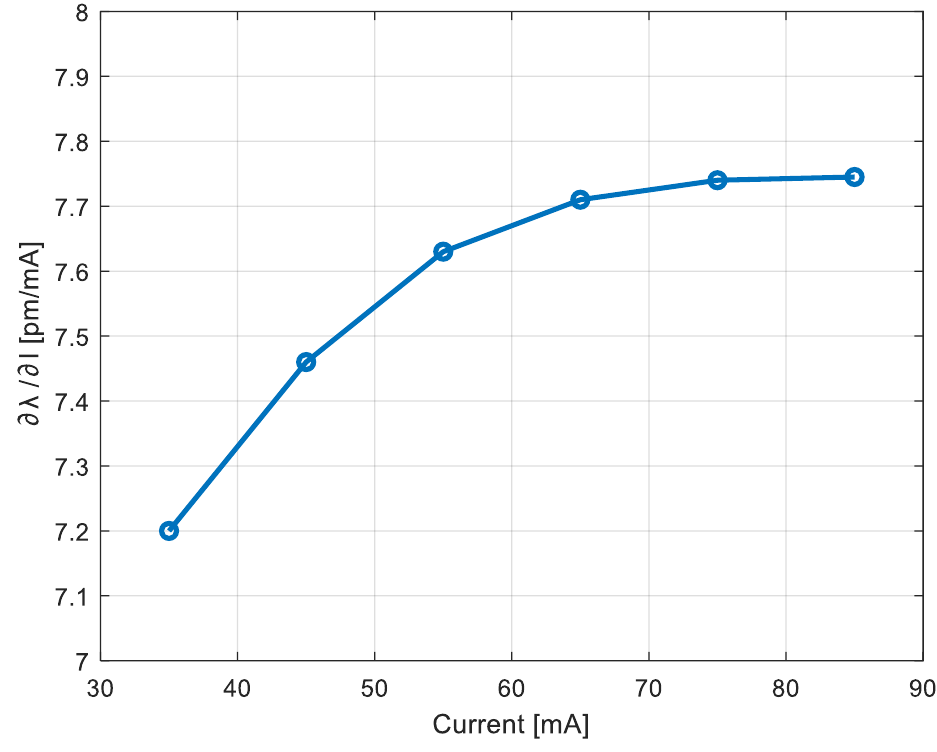
Figure 2. Measurement of ( ∂λ / ∂ I ) for the DFB laser WSLD-1550-020m-1-PD, as a function of the pump current.